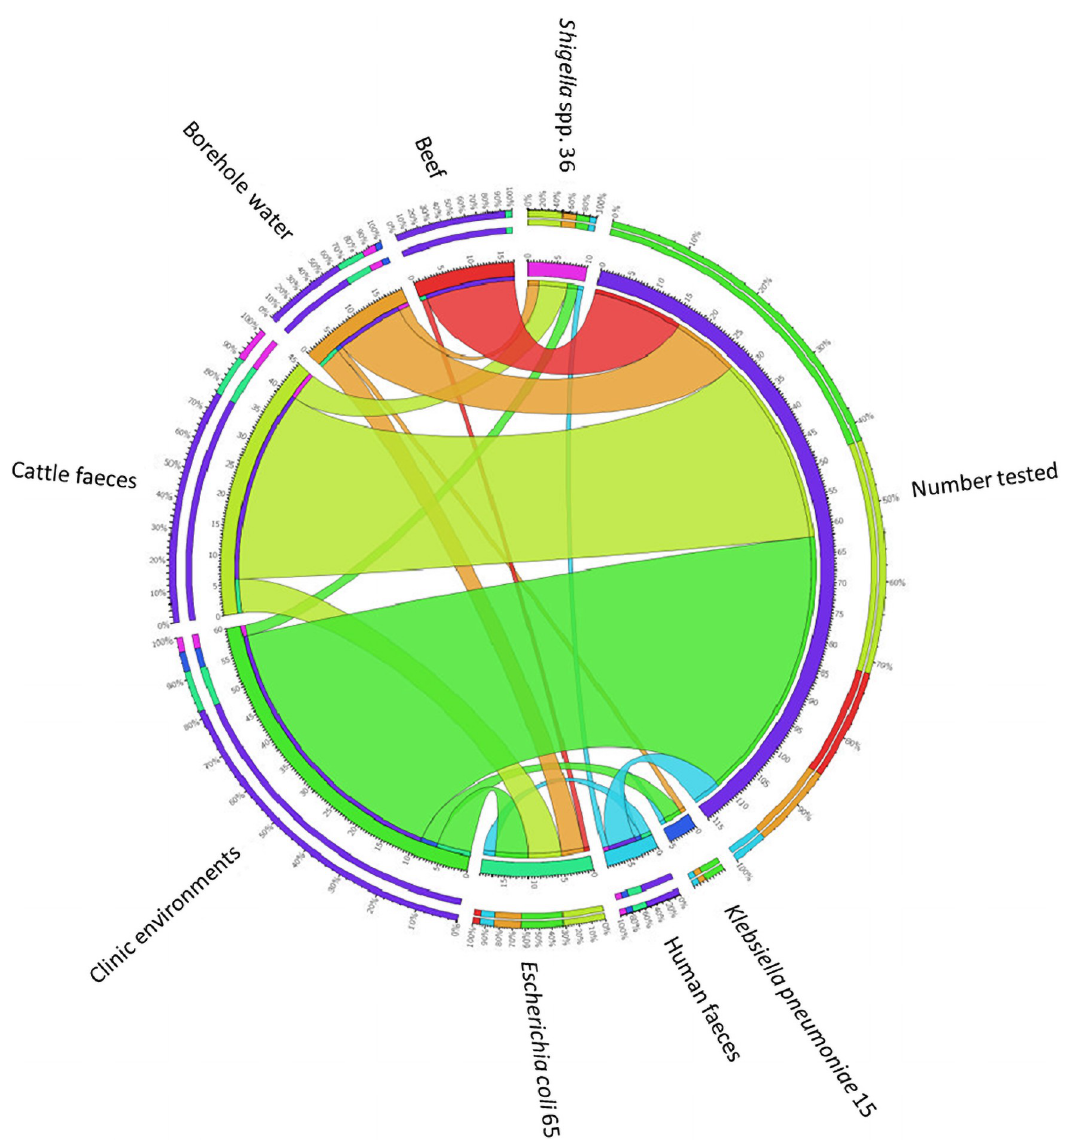
Fig 2. Proportion of ESBL-producing Enterobacteriaceae